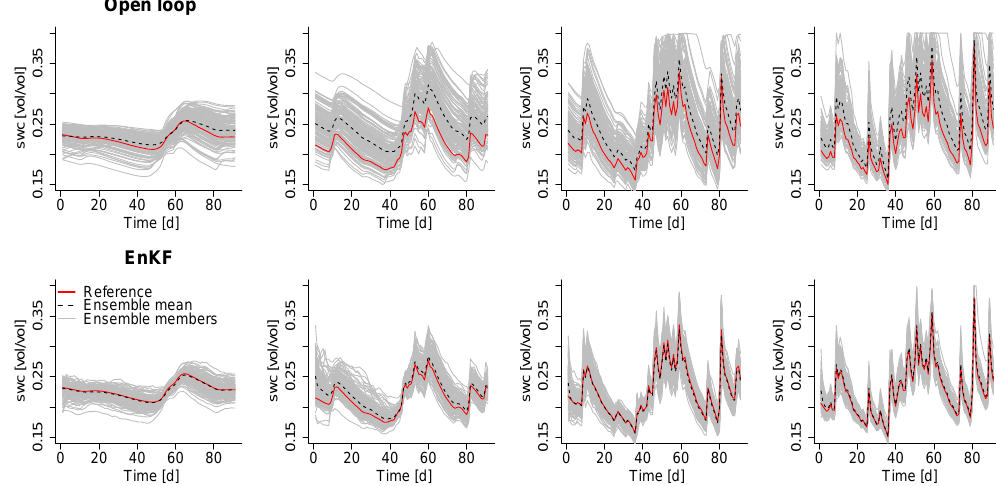
Figure 9. Simulated soil water content at the four verification nodes in Fig. 5 (from north to south) for April–June 2013 (91 days). Upper row shows results for open-loop simulations and lower row for